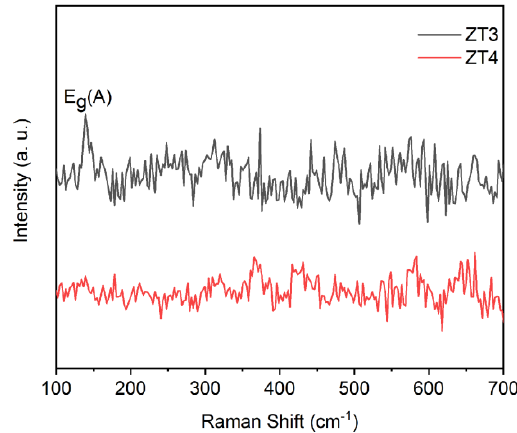
Figure 4. Raman spectrum of ZT3 and ZT4.